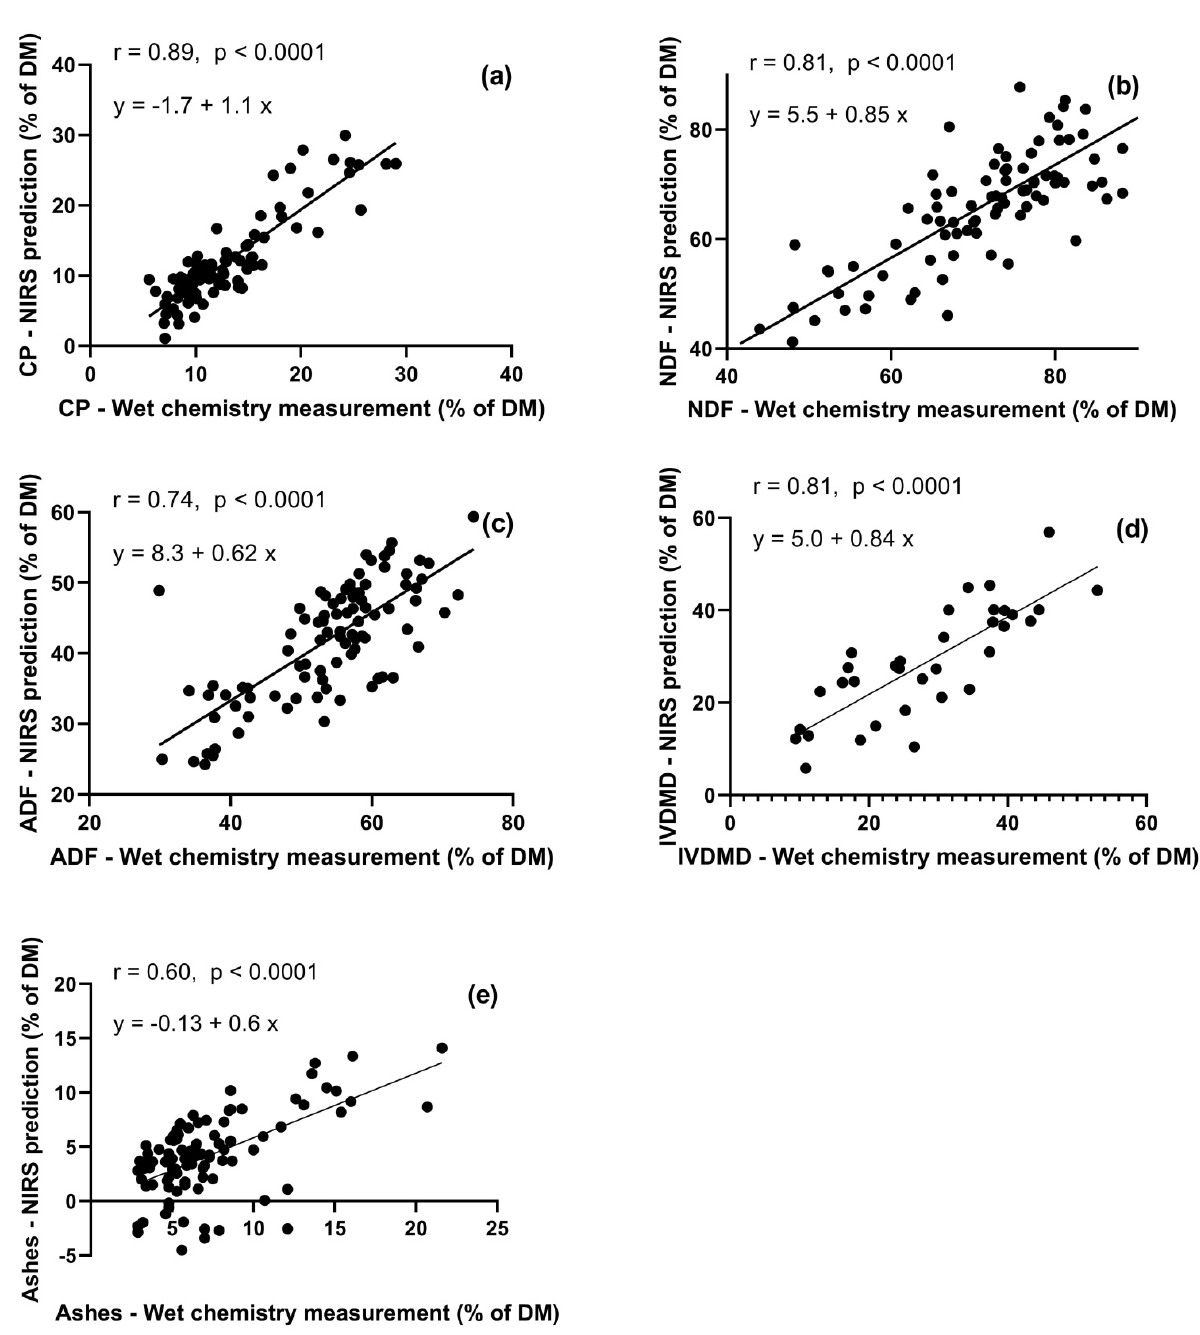
Figure 4. External validation of near-infrared spectrometry (NIRS) predictions with chemical measurements, of several nutritional constituents in gazelle rumen contents: CP ( a ), NDF ( b ), ADF ( c ), IVDMD ( d ), and ash ( e ). NIRS predictions were based on calibrations which used rangeland herbage and browse forage species (the Feeds dataset).